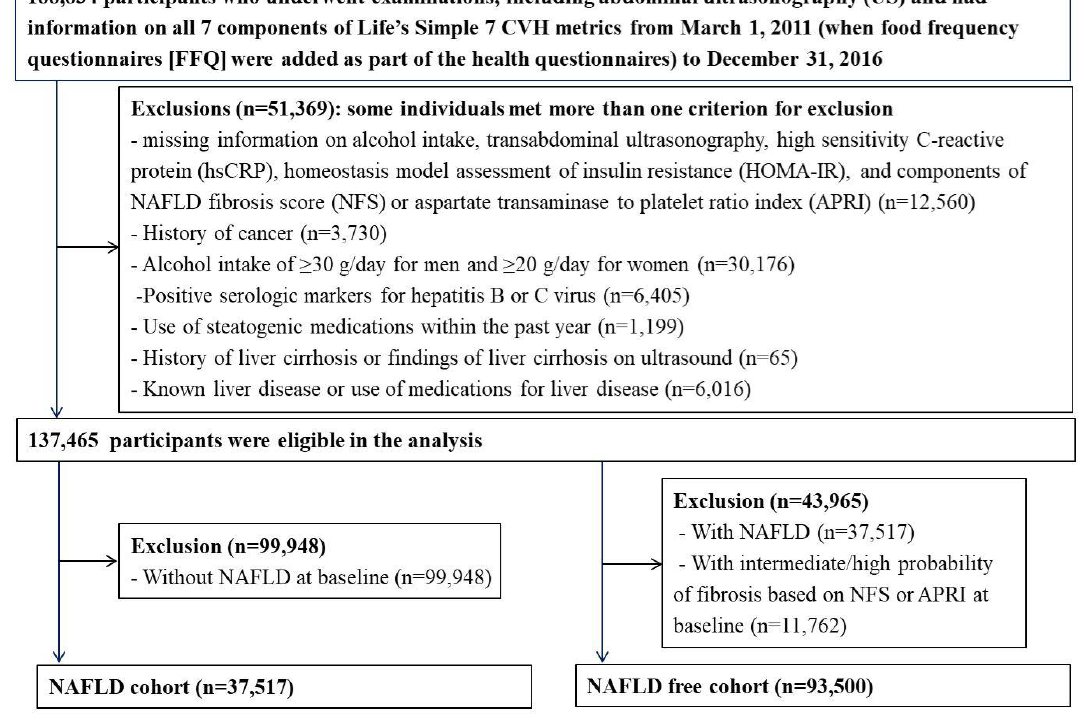
Figure 1. Flow diagram for the selection of study subjects. APRI, aspartate transaminase to platelet ratio index; FFQ, food frequency questionnaires; HOMA-IR, homeostasis model assessment of insulin resistance; hsCRP, high sensitivity C-reactive protein; NAFLD, non-alcoholic fatty liver disease; NFS, NAFLD fibrosis score; US, ultrasonography.